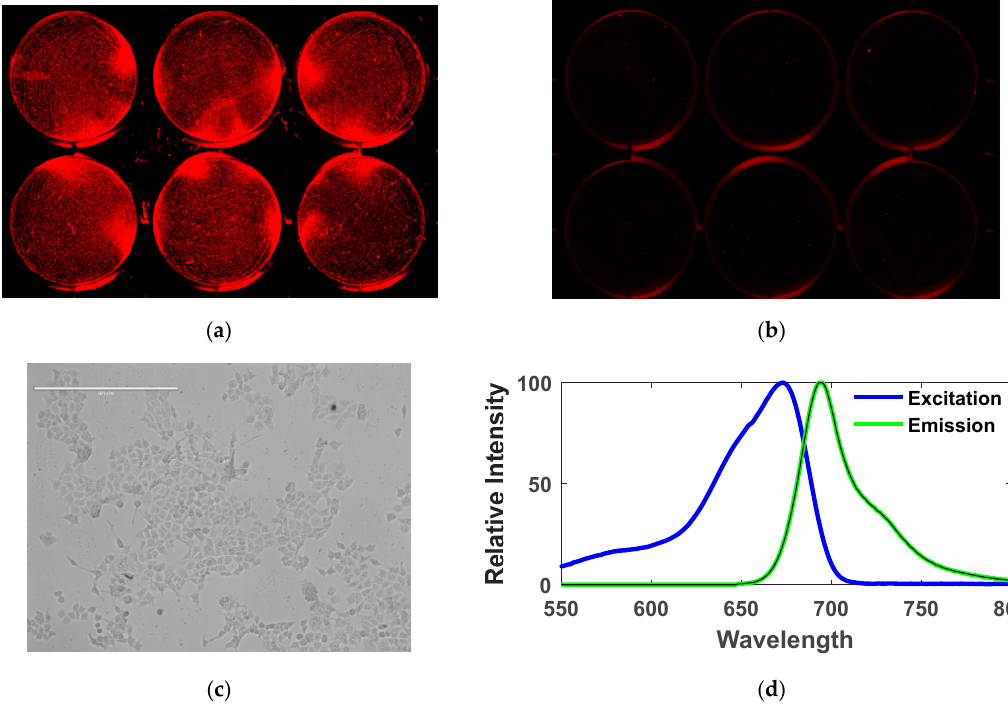
Figure 5. Detection of colorectal cancer cells expressing IRFP702: ( a ) colorectal cancer cells (HCT116) with IRFP702 fluorophore expression visualized under Odyssey CLx NIR scanner (LI-COR), ( b ) colorectal cancer cells (HCT116) without IRFP702 fluorophore expression visualized under Odyssey CLx NIR scanner (LI-COR), ( c ) colorectal cancer cells with IRFP702 fluorophore expression under EVOS Cell Imaging System, ( d ) excitation and emission spectra of IRFP702. This figure shows the absorption and emission spectra of the IRFP702 where the peak absorption and peak emission of the cultured sample is 673 nm and 702 nm respectively.